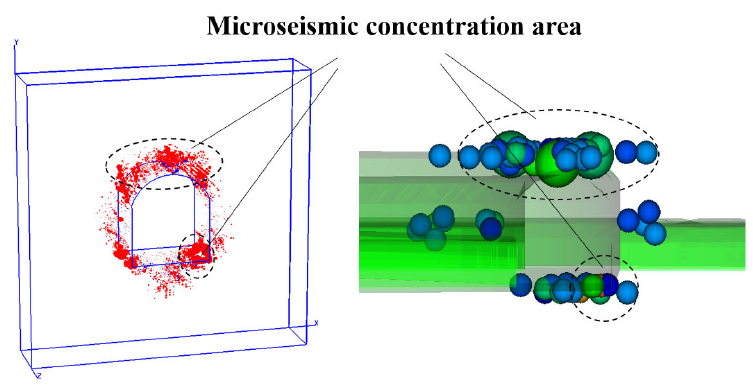
Figure 13. Comparison between numerical modeling and field monitoring.